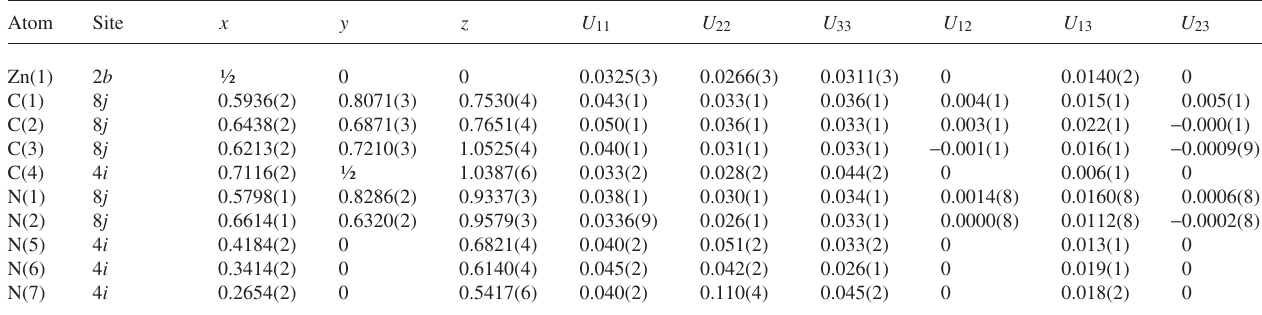
Table 3. Atomic coordinates and displacement parameters (in Å 2 )